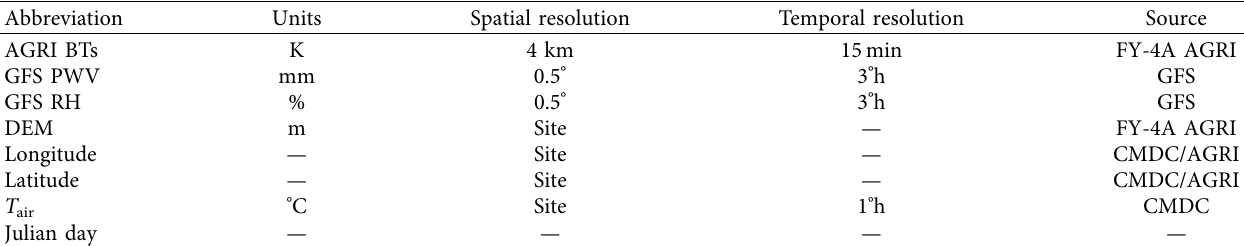
Figure 1: Elevation of study area and meteorological sites in China. Differently colored dots represent sites located at different elevations. Table 1: Temporal and spatial information of the primary data used in this